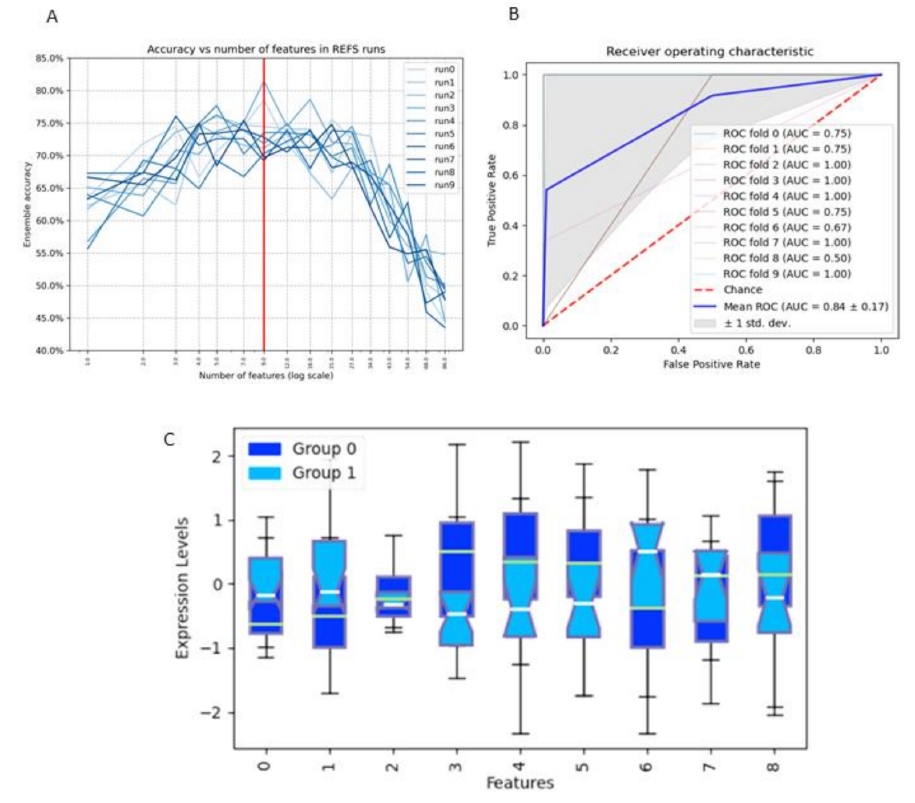
Figure 10. The datasheet of the entire study was analysed regarding marble burying (number of marbles buried) at 8 weeks of age (early adulthood). ( A ) After running the REFS algorithm 10 times, the best signature is at 9 features, with an average global accuracy of all classifiers of 0.73. ( B ) The optimal associated receiver-operating characteristic (ROC) curve for the best-performing classifier Ridge demonstrates an area under the curve (AUC) of 0.84 ± 0.17. ( C ) The 9 features separat- ing the two labels: 0 = Adlercreutzia, 1 = DH: tryptophan (nmol/gr), 2 = Lachnospiraceae Other, 3 = Dehalobacterium, 4 = Th17 cells in MLN, 5 = Activated Th2 cells in spleen, 6 = α -diversity (Shannon index), 7 = PFC: noradrenaline (nmol/gr), 8 = PFC: noradrenaline (nmol/gr), and 9 = Th1 cells in MLN. Label 0: number of buried marbles < 10. Label 1: number of buried marbles ≥